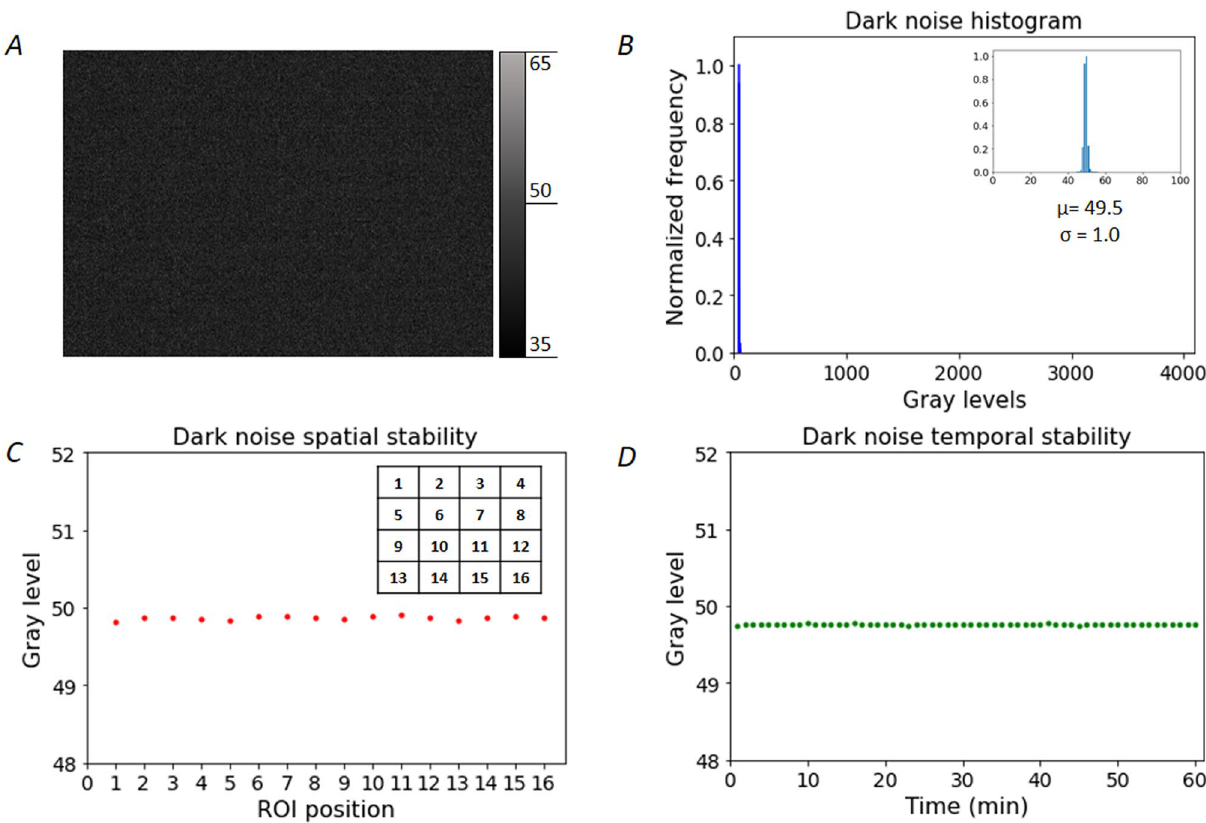
Figure 1. Camera dark and readout noise homogeneity and stability. (A) Representative dark image. (B) Corresponding histogram of grey levels. Insert is a zoom on non-zero histogram levels. (C) Spatial uniformity of noise, the sensor was divided to 16 regions of identical dimensions numbered from 1 to 16. (D) Temporal stability of noise evaluated as the mean grey level of the whole